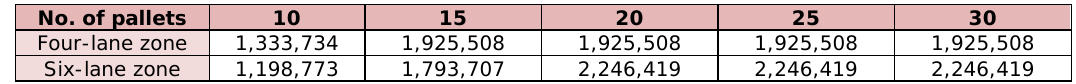
Figure 9. “Express zone layout screen”. Source: authors